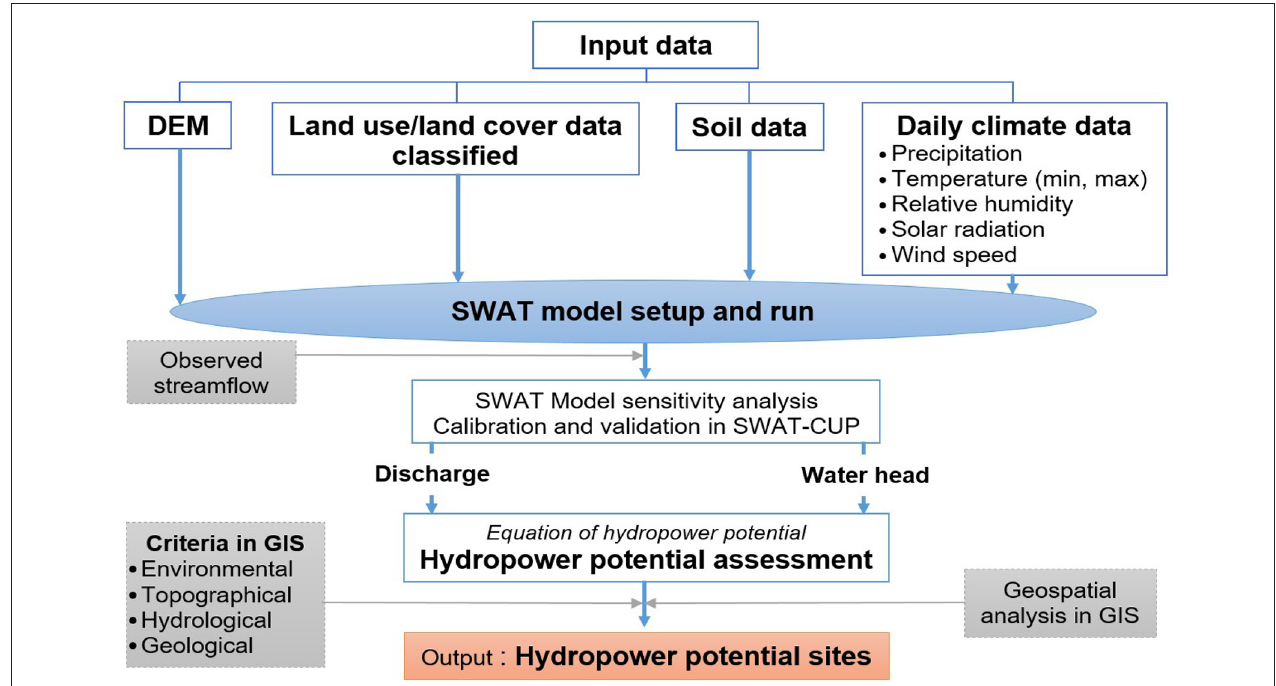
FIGURE 3 | Methodological framework for hydropower potential assessment.